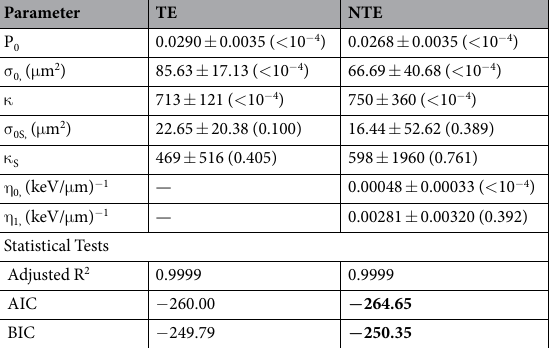
Table 1. Parameter estimates for combined ion data sets for targeted effects (TE) and non-targeted effects (NTE) models for the dose response for fraction tumor prevalence. Parameter fits and standard deviations (including p-values) are described using survival function parameters m s = 3 and D 0 = 2.6 Gy, and tumor induction parameter m = 3. The model providing the optimal fit (lowest AIC or BIC values) is shown in bold-